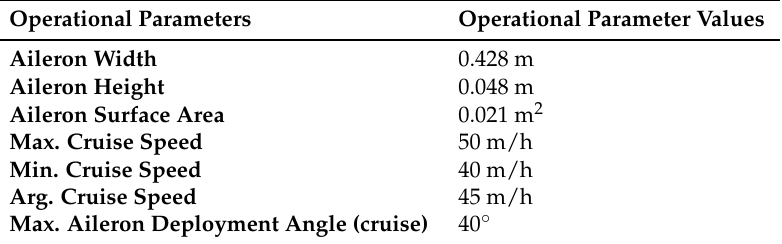
Table 1. Aircraft Specifications.